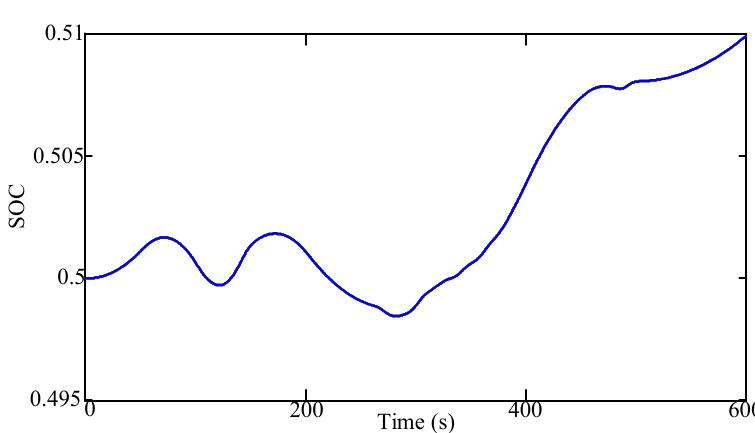
Figure 16. The power states of all the individual ACs.